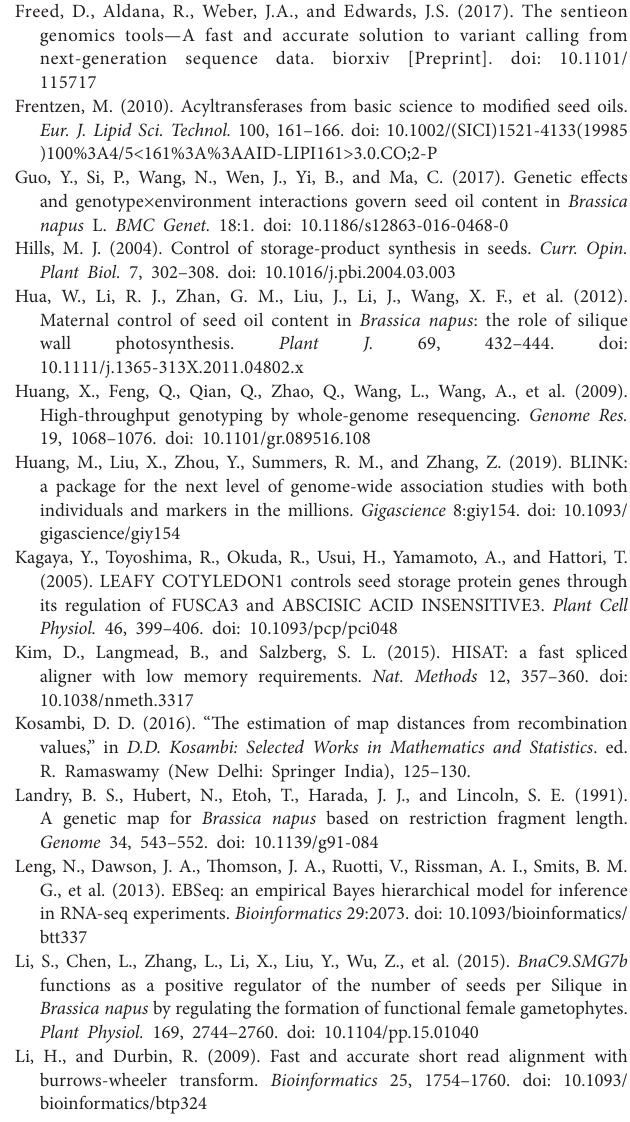
Supplementary Figure 2 | The correlations between environments for the association and RIL population. (A) The correlations for the association population. (B) The correlations for the RIL population. Supplementary Figure 3 | The density of SNP covered in 19 Brassica napus chromosome for GWAS. Supplementary Figure 4 | GWAS for the SOC trait in consecutive 3 years based on BLINK. Supplementary Figure 5 | Genotype map based on the Bin markers of the total 158 RILs. Supplementary Figure 6 | The effect analysis of the major QTL for SOC in 2015–2016 GY. AA and BB was the genotype of each flanking markers linked the major QTL in the two parents. The ‘ n ’ represented the number lines in the RIL population conferring the corresponding genotype. *** represented significance level of the Student’s t -test, p < 0.001. Supplementary Figure 7 | QTLs for TSW and SOC identification in previous